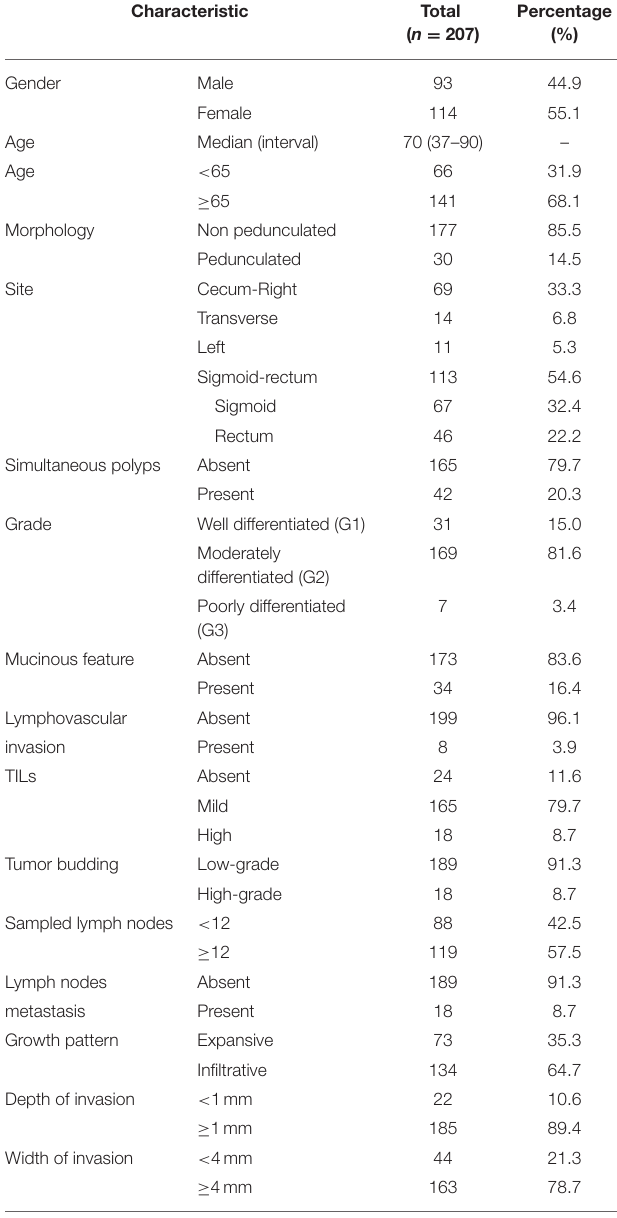
TABLE 1 | Clinical and histopathological variables evaluated in our